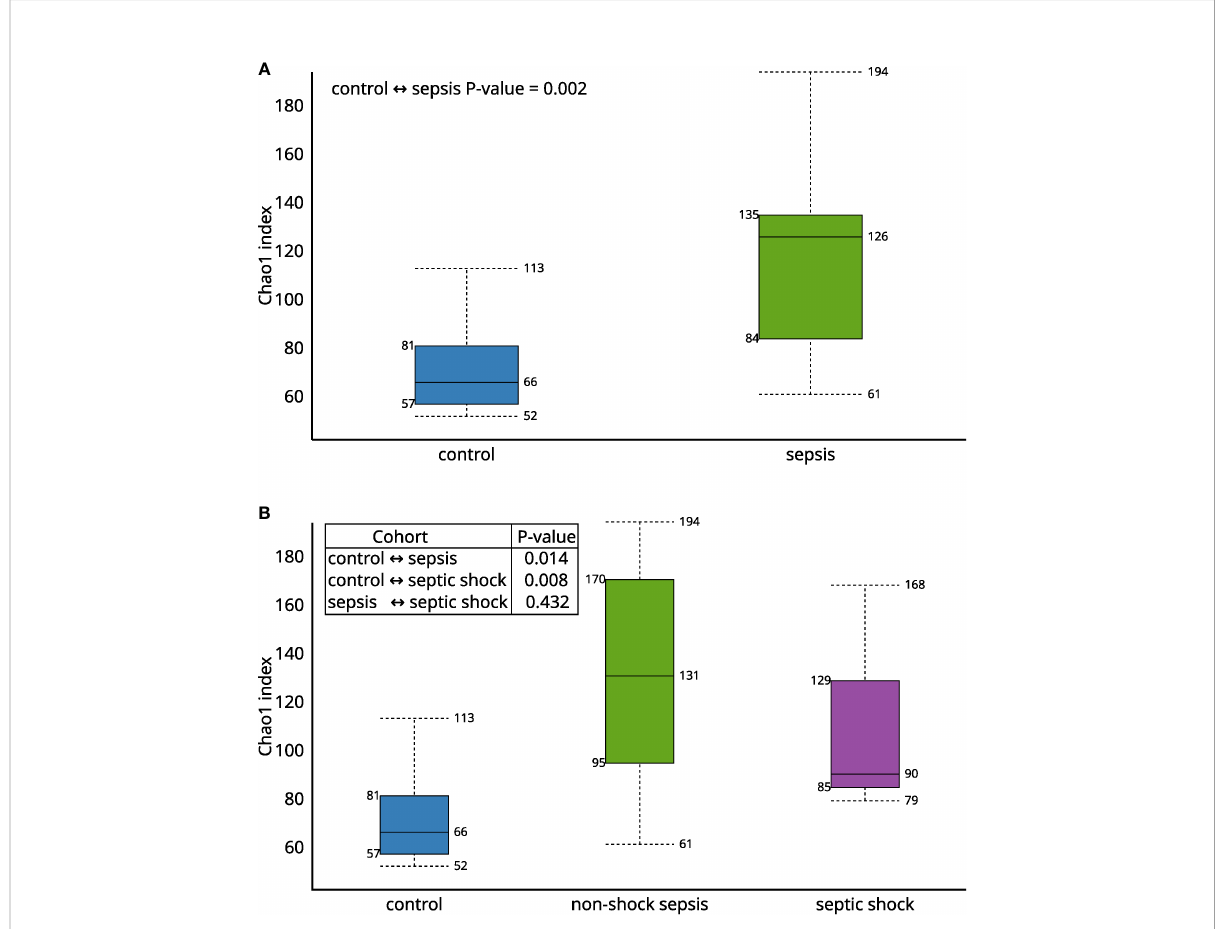
FIGURE 1 The Chao1 alfa diversity between (A) septic and control patients; (B) patients with non-shock sepsis, septic shock and control patients: The difference of alpha diversities between control/septic, control/non-shock septic and control/septic shock patients are signi fi cant. There is no signi fi cant difference between the two septic